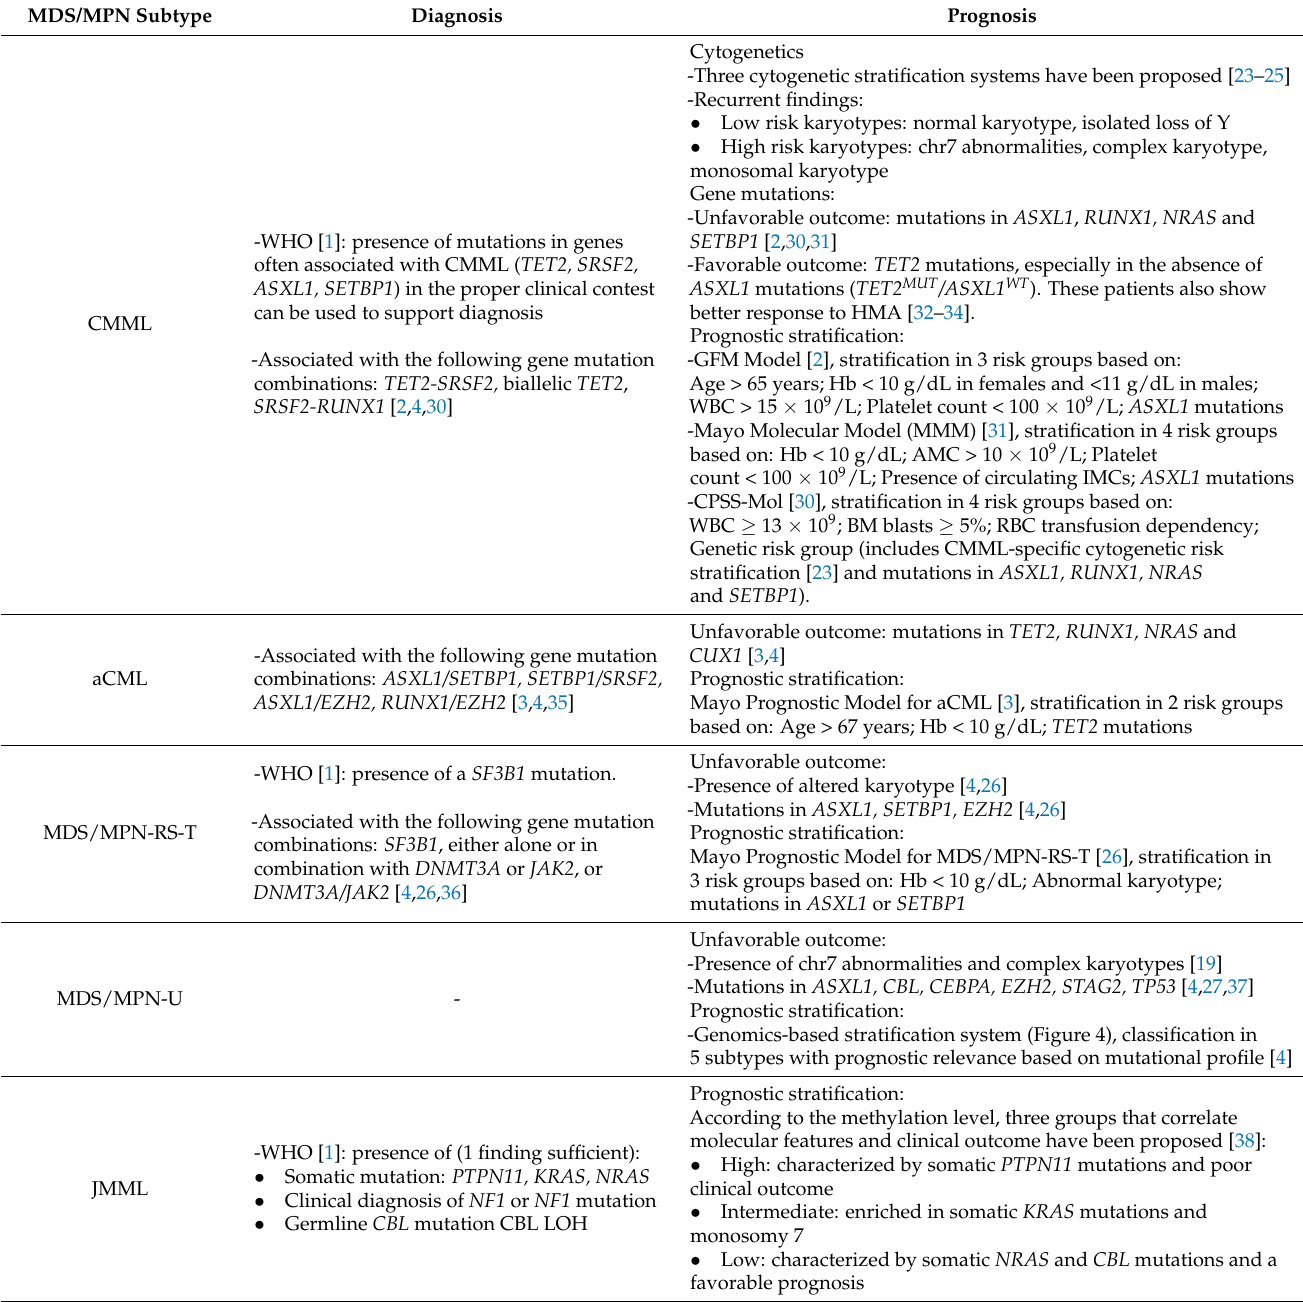
Table 2. Clinical relevance of cytogenetic abnormalities and gene mutations in